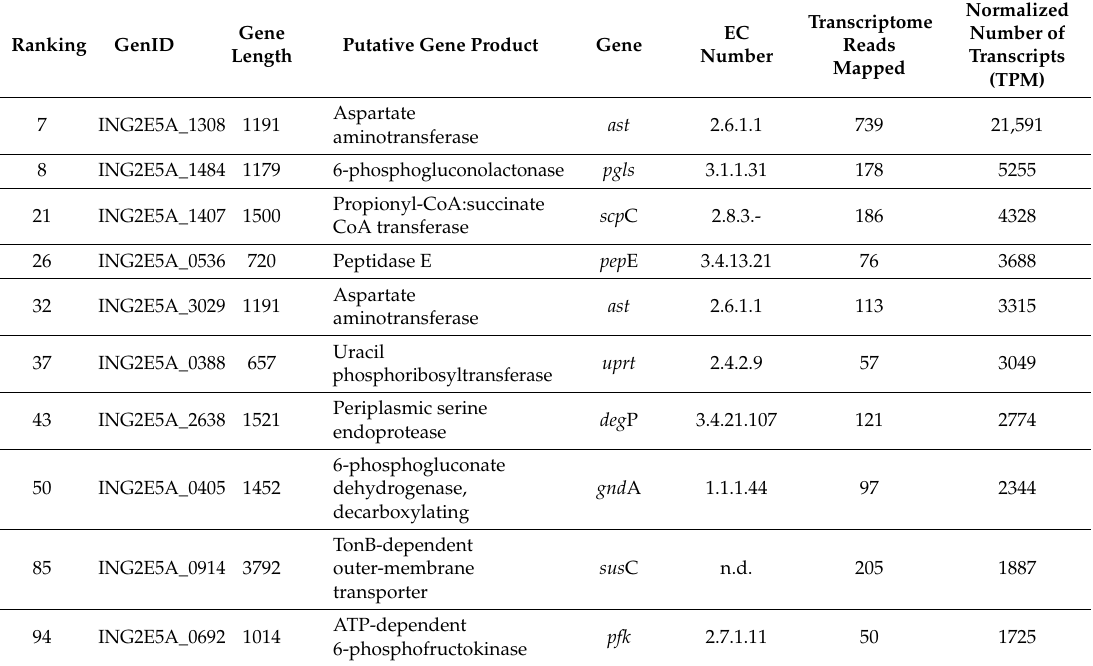
Table 3. Most actively transcribed genes for enzymes involved in carbohydrate or amino acid utilization in P. mucosa which were ranked by TPM values from highest to lowest as deduced from